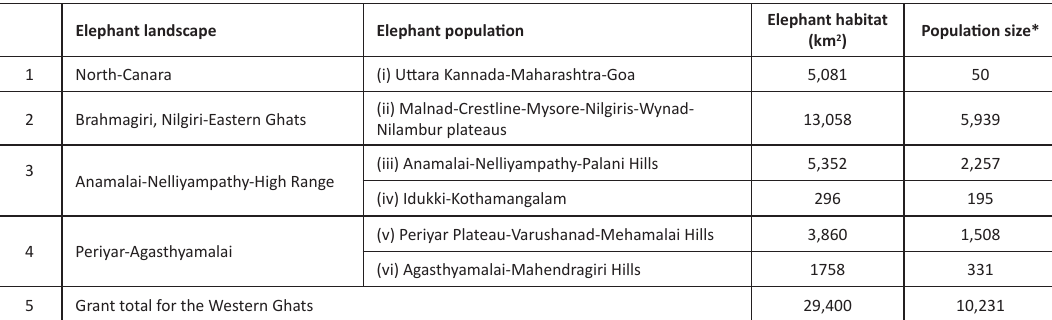
Table 1. The elephant landscapes and populations in Western Ghats